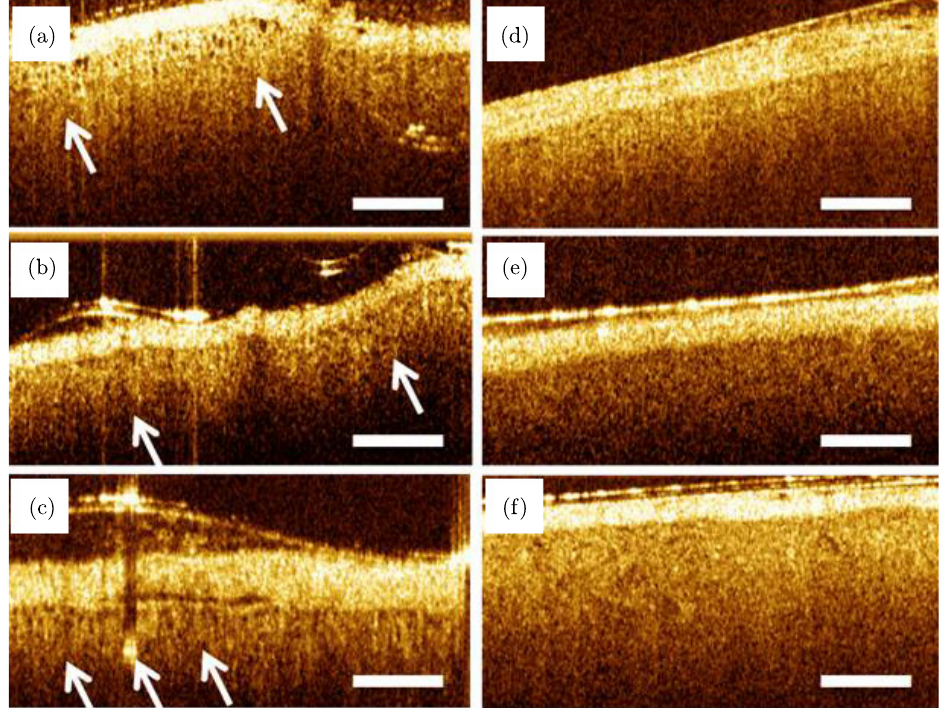
Fig. 2. Ex vivo OCT imaging of human donor kidney. Each is a representative OCT image from di®erent human subject (a) – (c) shows opening tubules (see arrows), while in (d) – (f), most of the tubules are closed. Scale bar ¼ 500 (cid:1)